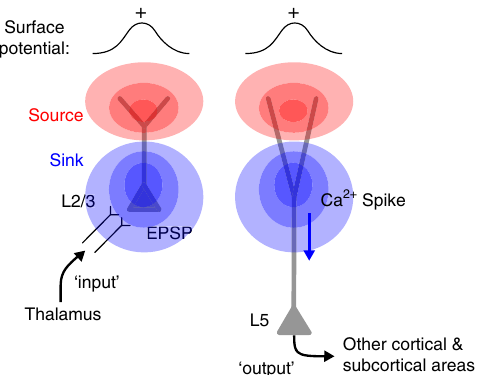
Fig. 8 Diagram of the possible cellular mechanisms underlying surface positive potentials. The conventional view of surface positive potentials is that they are generated primarily by synaptic inputs from other cortical and subcortical regions to L2/3 pyramidal neurons through L4 ( left ) 51, 52 . We found that dendritic Ca 2+ spikes of L5 pyramidal neurons (that lead to burst fi ring of these cells) could also generate the surface positive potentials ( right